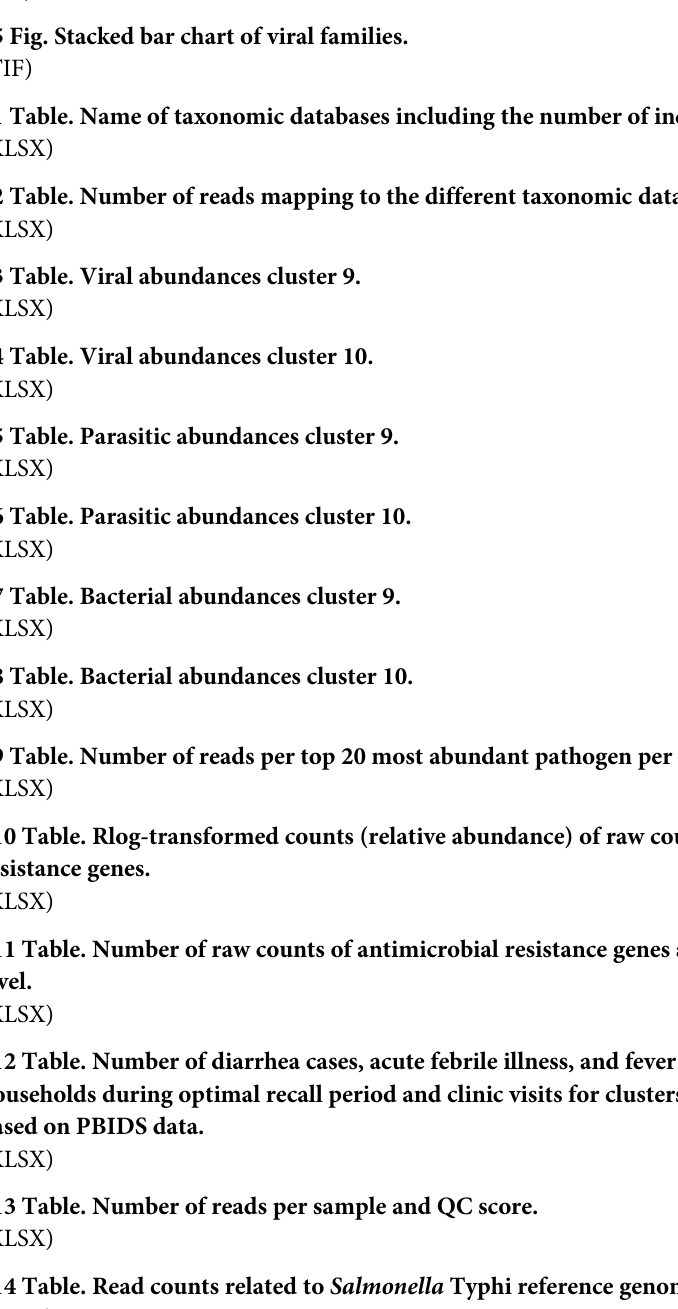
S5 Fig. Stacked bar chart of viral families. S1 Table. Name of taxonomic databases including the number of included species. S2 Table. Number of reads mapping to the different taxonomic databases and species. S3 Table. Viral abundances cluster 9. S4 Table. Viral abundances cluster 10. S5 Table. Parasitic abundances cluster 9. S6 Table. Parasitic abundances cluster 10. S7 Table. Bacterial abundances cluster 9. S8 Table. Bacterial abundances cluster 10. S9 Table. Number of reads per top 20 most abundant pathogen per sample. S10 Table. Rlog-transformed counts (relative abundance) of raw counts of antimicrobial resistance genes. S11 Table. Number of raw counts of antimicrobial resistance genes aggregated on gene level. S12 Table. Number of diarrhea cases, acute febrile illness, and fever cases reported in households during optimal recall period and clinic visits for clusters 9, 10 and all clusters based on PBIDS data. S13 Table. Number of reads per sample and QC score. S14 Table. Read counts related to Salmonella Typhi reference genomes. S15 Table. FPKM-values per antimicrobial resistance